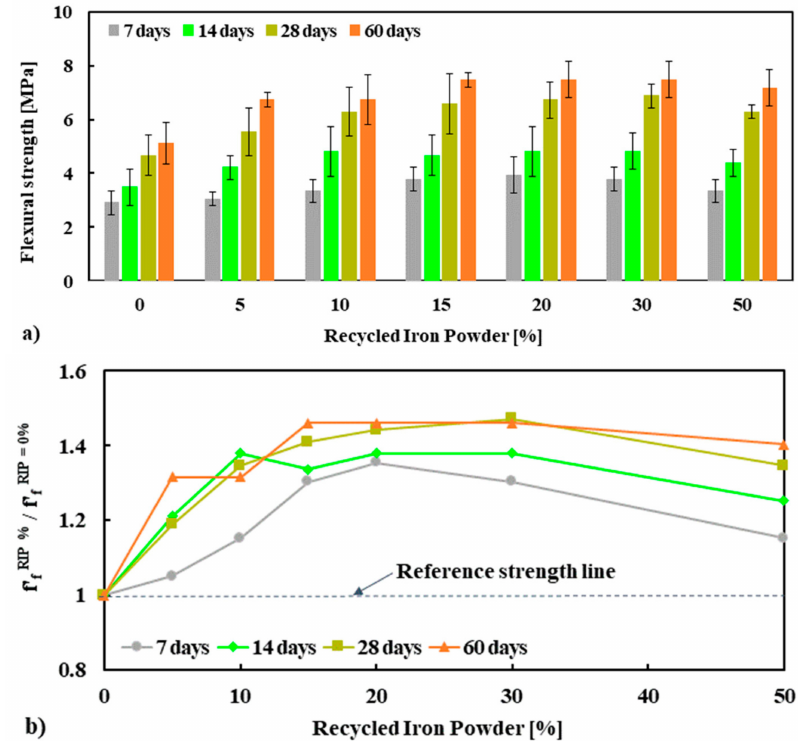
Figure 6. Flexural strength (f (cid:48) f) ( a ) and normalized f (cid:48) f ( b ) of mortars specimens performed at 7, 14, 28 and 60